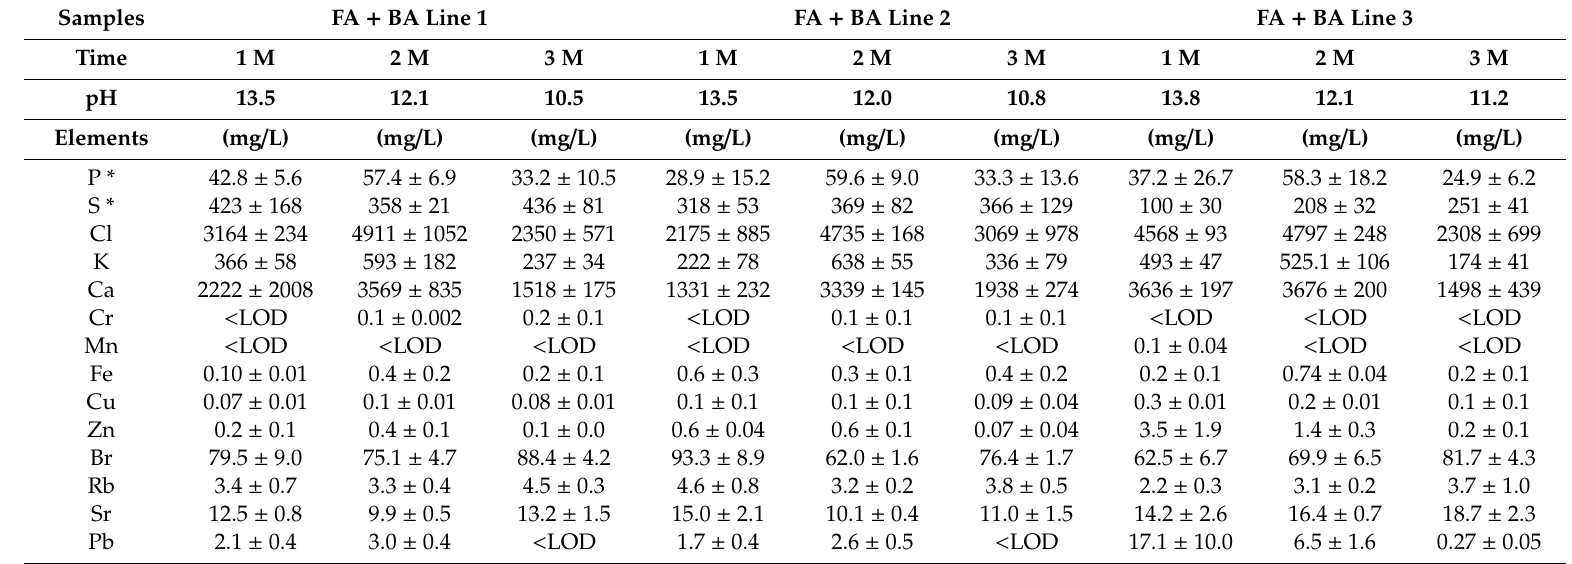
Table 3. Results of the TXRF analysis and pH values of samples stabilized following the a) procedure with Sewage-MSWI FA from di ff erent lines after (1), (2) and (3)